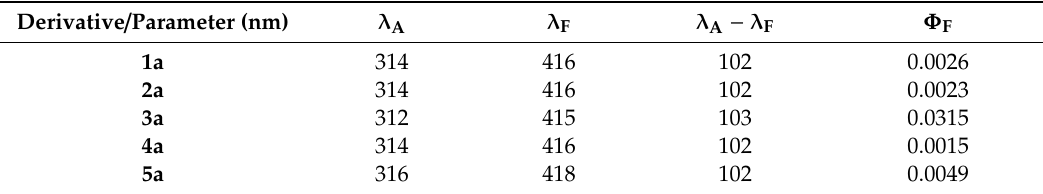
Table 2. Photophysical characteristics of 1a – 5a derivative.